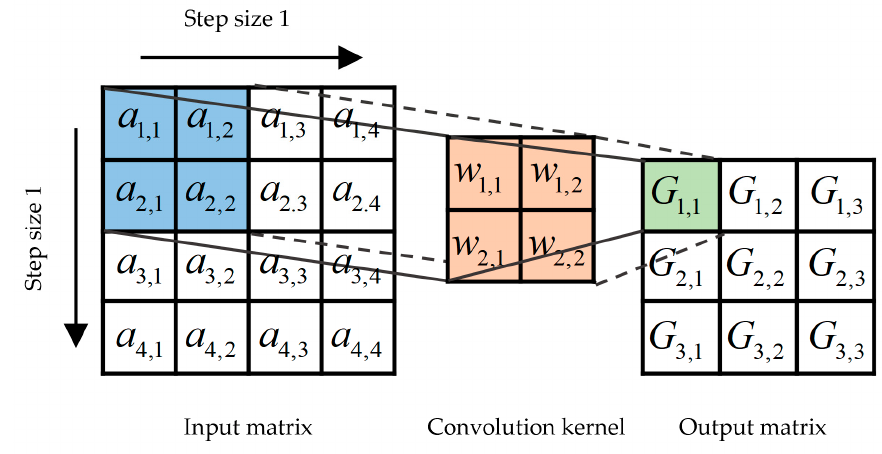
Figure 1. Example of the 2D convolution operation.